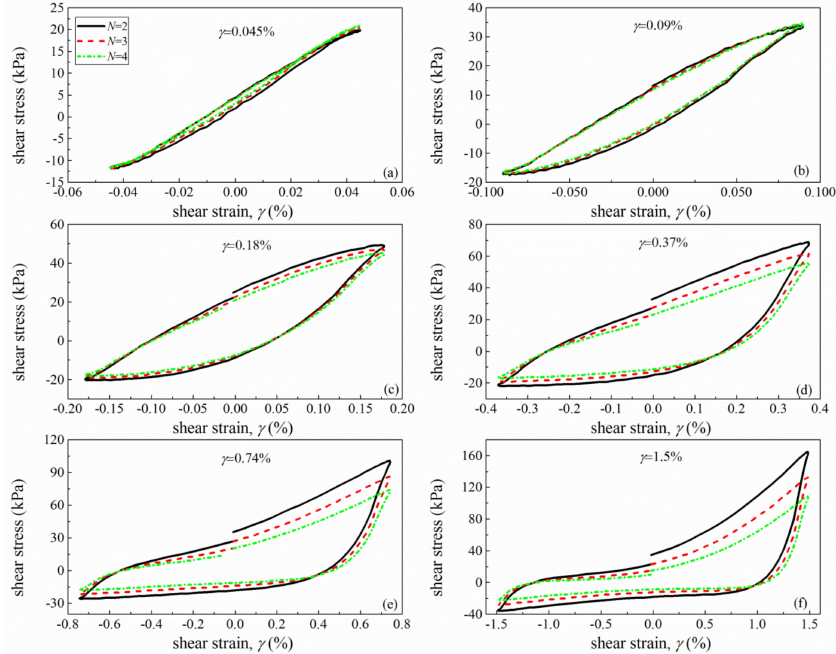
Figure 6. Hysteresis loops of N = 2~4 for increasing γ ( a ) γ = 0.045%, ( b ) γ = 0.09%, ( c ) γ = 0.18%, ( d ) γ = 0.37%, ( e ) γ = 0.74%, ( f ) γ = 1.5% ( D r = 50% and σ c = 100